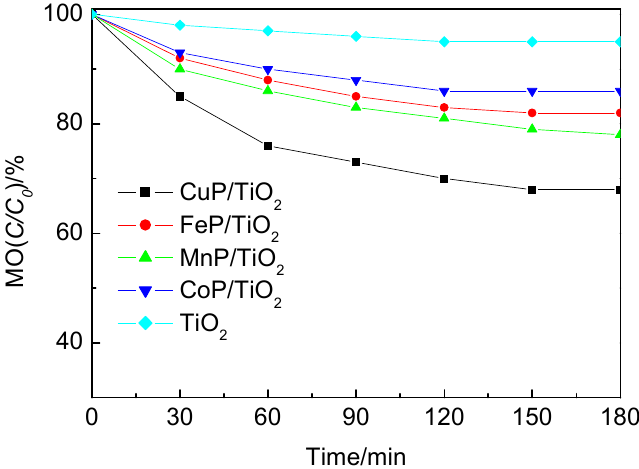
and MP-TiO catalysts under visible light 2 2